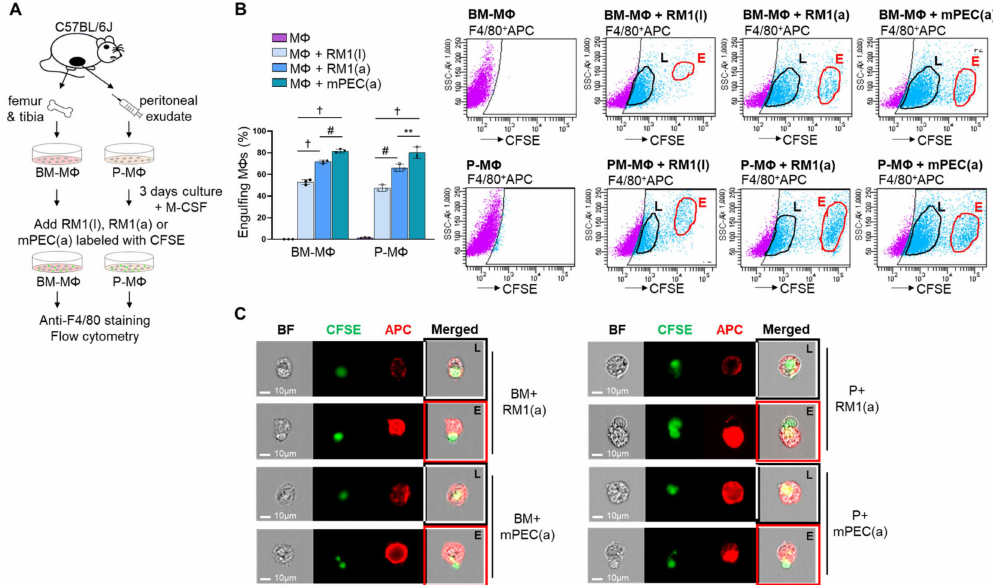
Figure 1. E ff erocytosis of apoptotic prostate cancer cells and normal prostate epithelial cells by bone marrow-derived (BM) and peritoneal (P) macrophages (M Φ ). ( A ) BM-M Φ and P-M Φ isolation and in vitro culture. Prostate cancer (RM1) and normal prostate ephitelial (mPEC) cells were exposed to UV to induce apoptosis and RM1(l), RM1(a), and mPEC(a) were stained with cell-trace-CFSE. BM-M Φ and P-M Φ were co-cultured with live prostate cancer RM1(l), apoptotic prostate cancer RM1(a) cells, and apoptotic normal prostate epithelial mPEC(a) cells. The co-cultures were stained with anti-F4 / 80-APC. ( B ) Flow cytometry analysis from A. Gates were adjusted to IgG isotype control. ( C ) Representative images from ImageStream show macrophages (F4 / 80-APC + , red) engulfing RM1(a) and mPEC(a) cells (CSFE + , green) in the early (E, red line) and late (L, black line) internalization stages. BF, bright field; BM + , bone marrow macrophages; P + , peritoneal macrophages. Data are mean ± SEM, n = 4 per group; ** p < 0.01, # p < 0.001, † p < 0.0001 (one-way analysis of variance (ANOVA); Dunnet’s multiple-comparisons